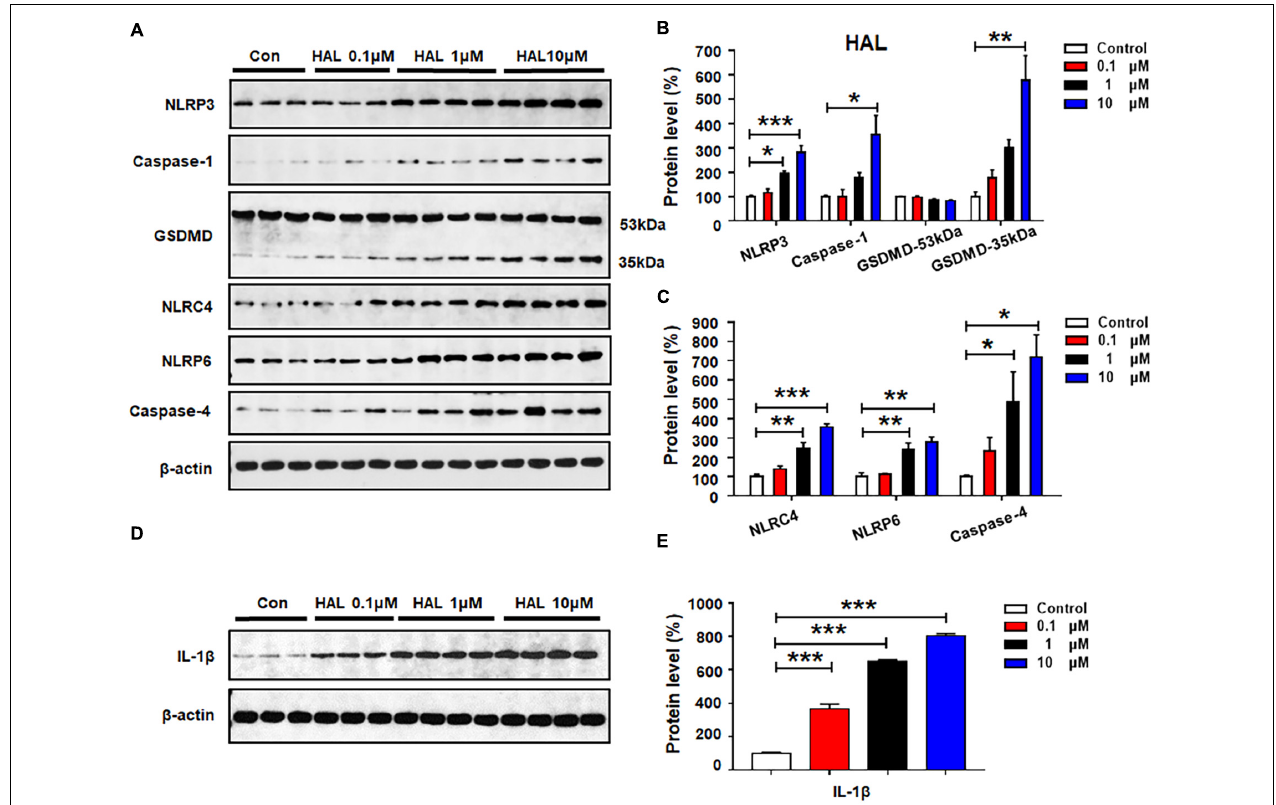
FIGURE 5 | Haloperidol treatment activated NLRP3/caspase-1 signaling and increased NLRC4, NLRP6, and IL-1 β protein expression in cultured astrocytes. Cells were treated with 0.1, 1, or 10 µ M haloperidol for 24 h. (A–E) Western blot was used to examine the expression of NLRP3, caspase-1 (20 kDa), GSDMD (53 and 35 kDa), NLRC4, NLRP6, and IL-1 β . The data are presented as the mean ± standard error of the mean. * p < 0.05, ** p < 0.01, *** p < 0.001 vs. control (one-way analysis of variance and post hoc Dunnett’s multiple comparison test; n = 3–4 cultures/western blot group). Con, control; HAL,